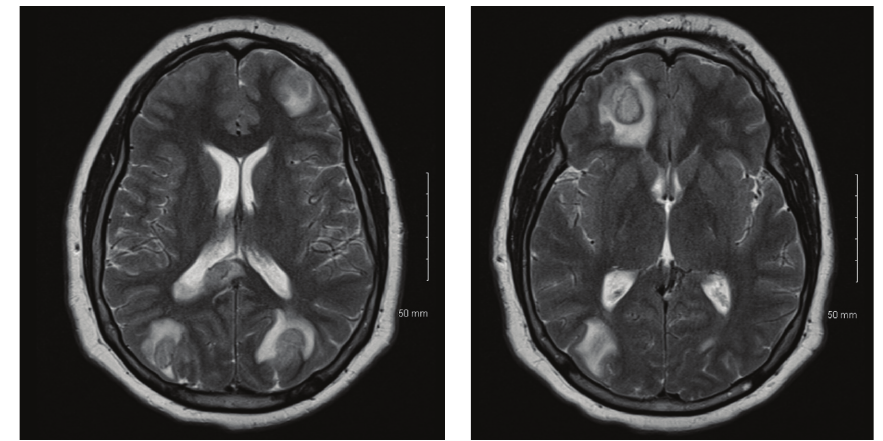
Figure 1: Brain MRI with contrast showing multiple ring-enhancing lesions and leptomeningeal enhancement.